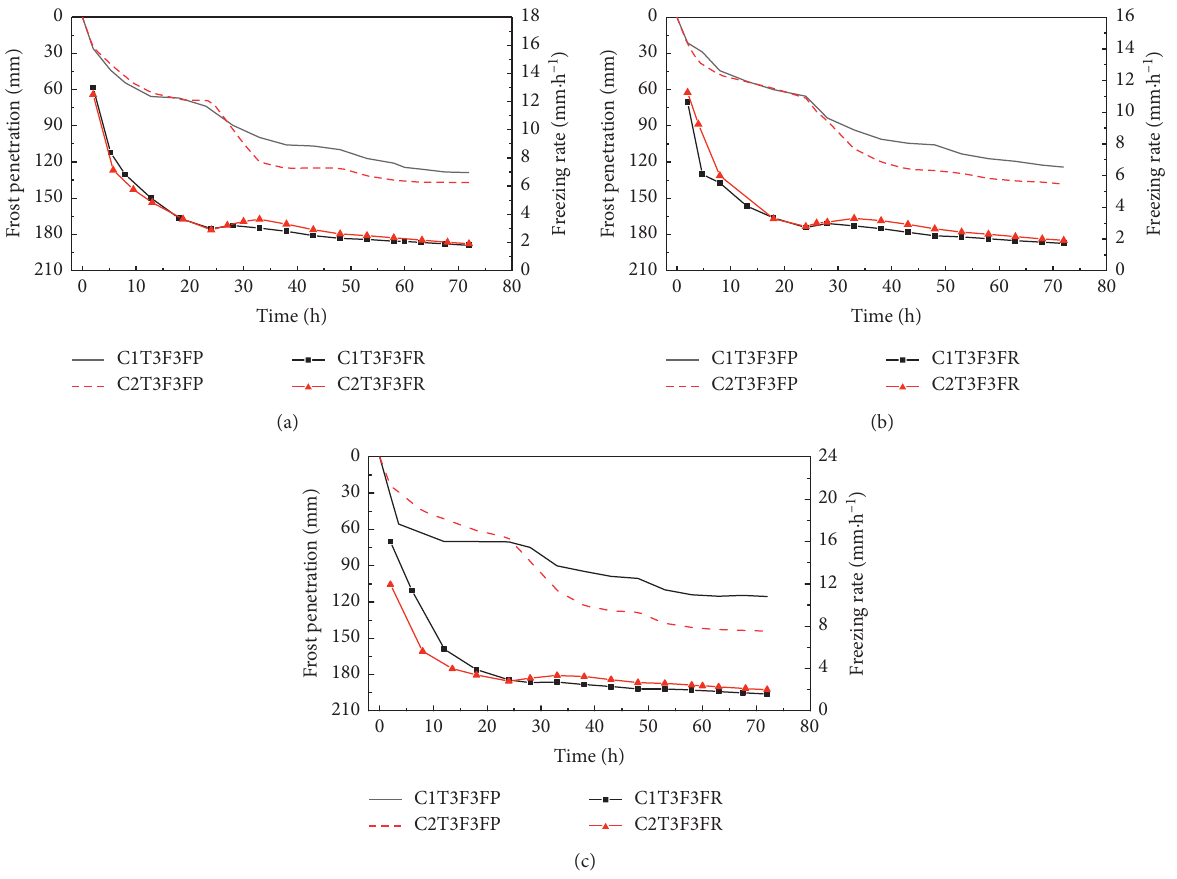
Figure 5: Variation of frost penetration and freezing rate during three freezing processes of C1T3F3 and C2T3F3 samples. (a) The first freezing. (b) The second freezing. (c) The third freezing.